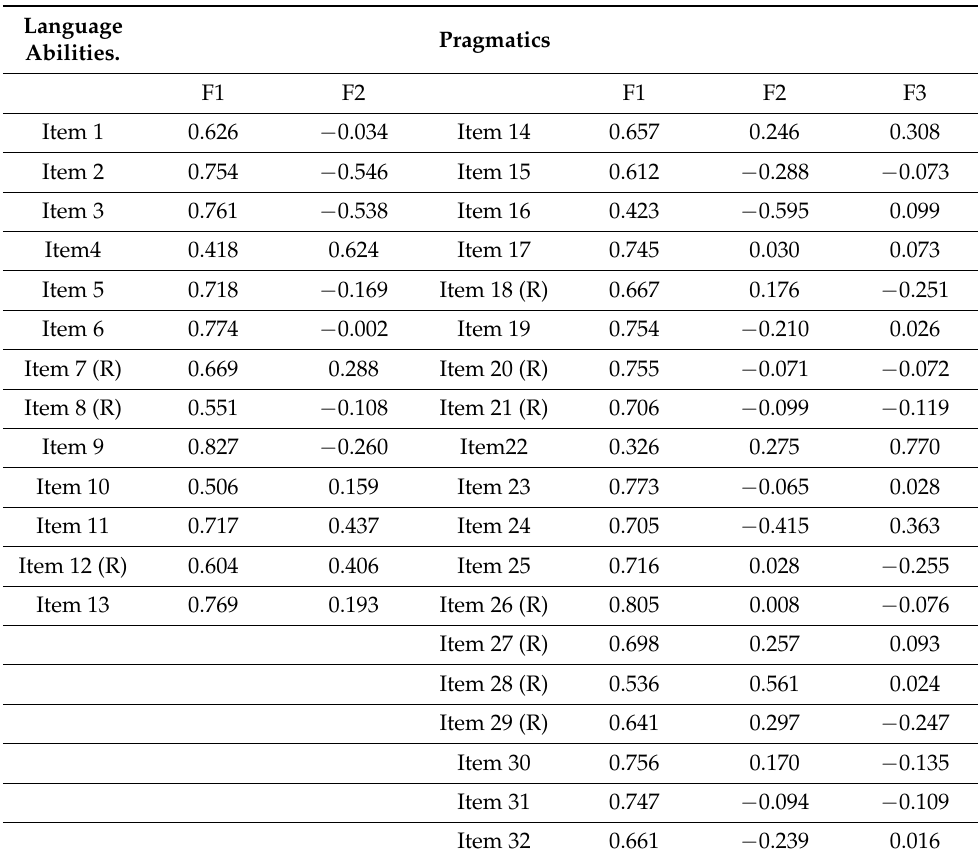
Table 6. Factor Loadings: grey highlighting indicates